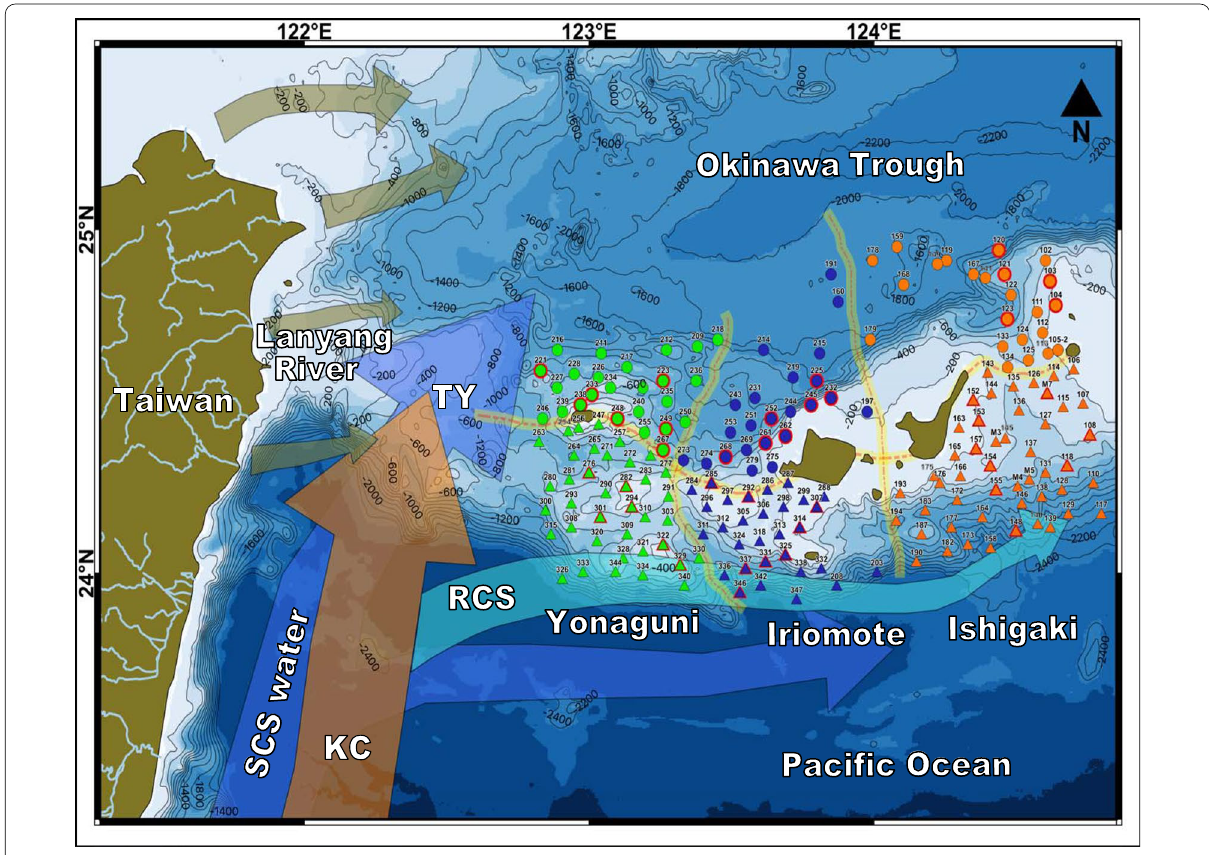
Fig. 2 Sampling sites in the study area. Circles and triangles represent sites on the Okinawa Trough and Pacific sides of the southern Ryukyu Island Arc, respectively. Green, blue, and orange symbols indicate sites in the Yonaguni, Iriomote, and Ishigaki subareas, respectively. Circles and triangles with red borders indicate sites where sediment samples were collected for Nd isotope analysis. For abbreviations, see Fig.